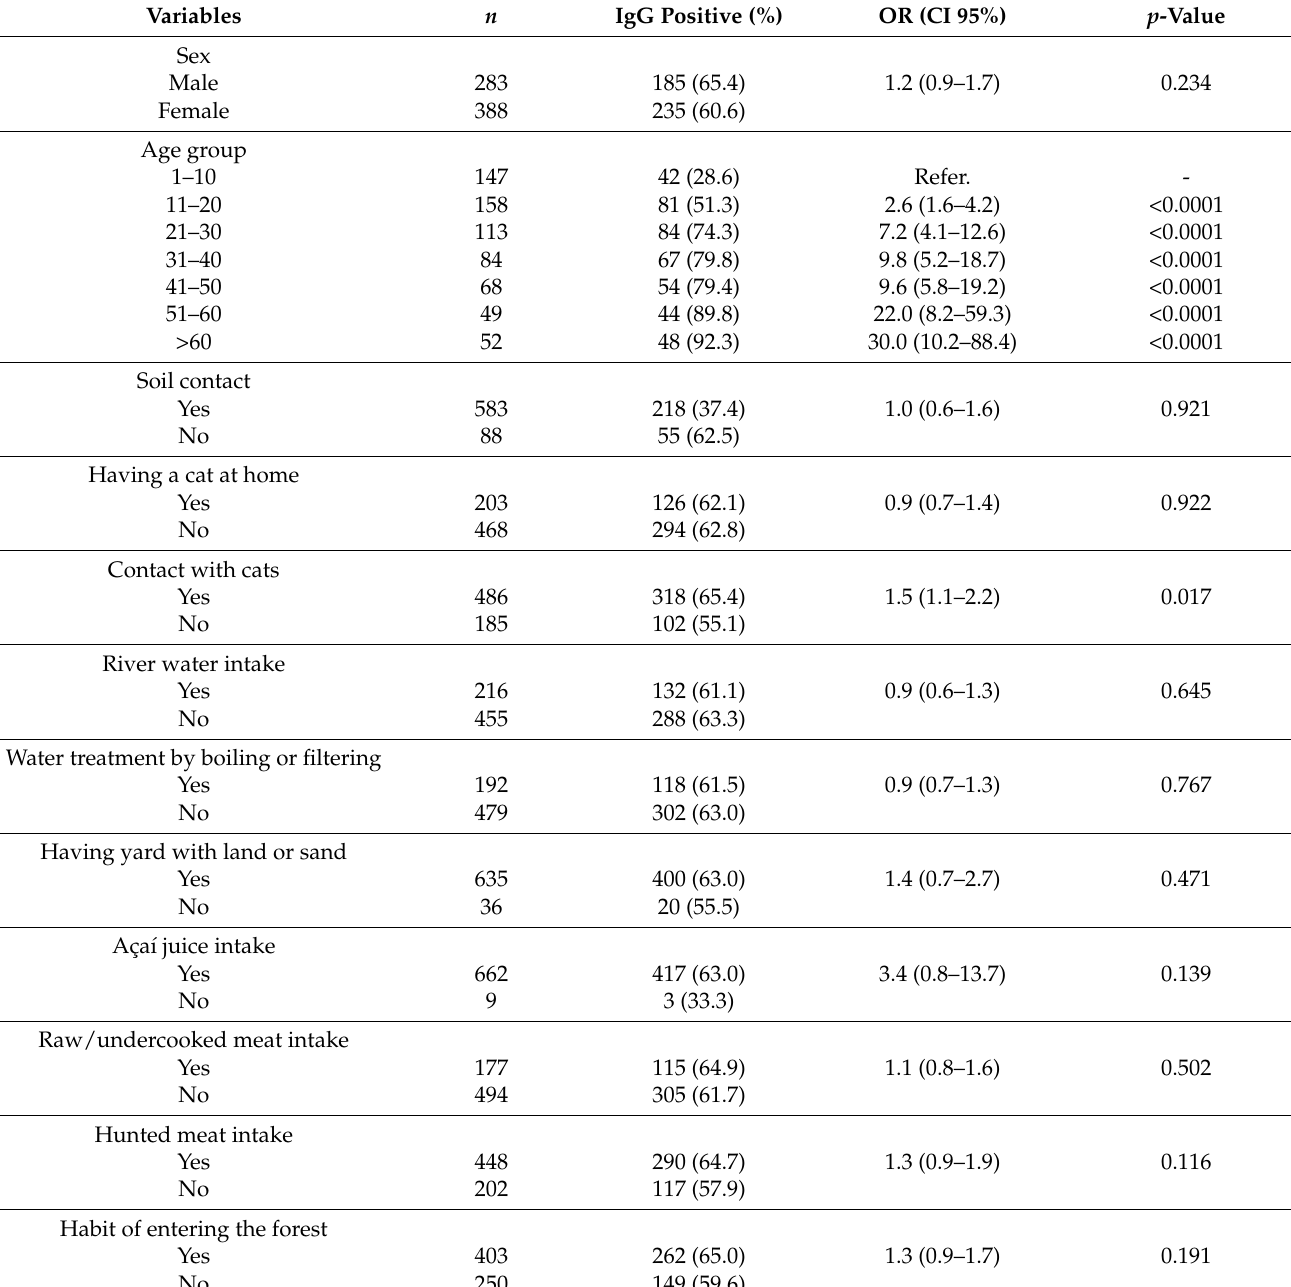
Table 2. Bivariate analysis between the variables studied and the seropositivity of IgG anti- T. gondii in individuals residing in the rural area of the municipality of Ponta de Pedras, Par á , Brazil, from August 2015 to April